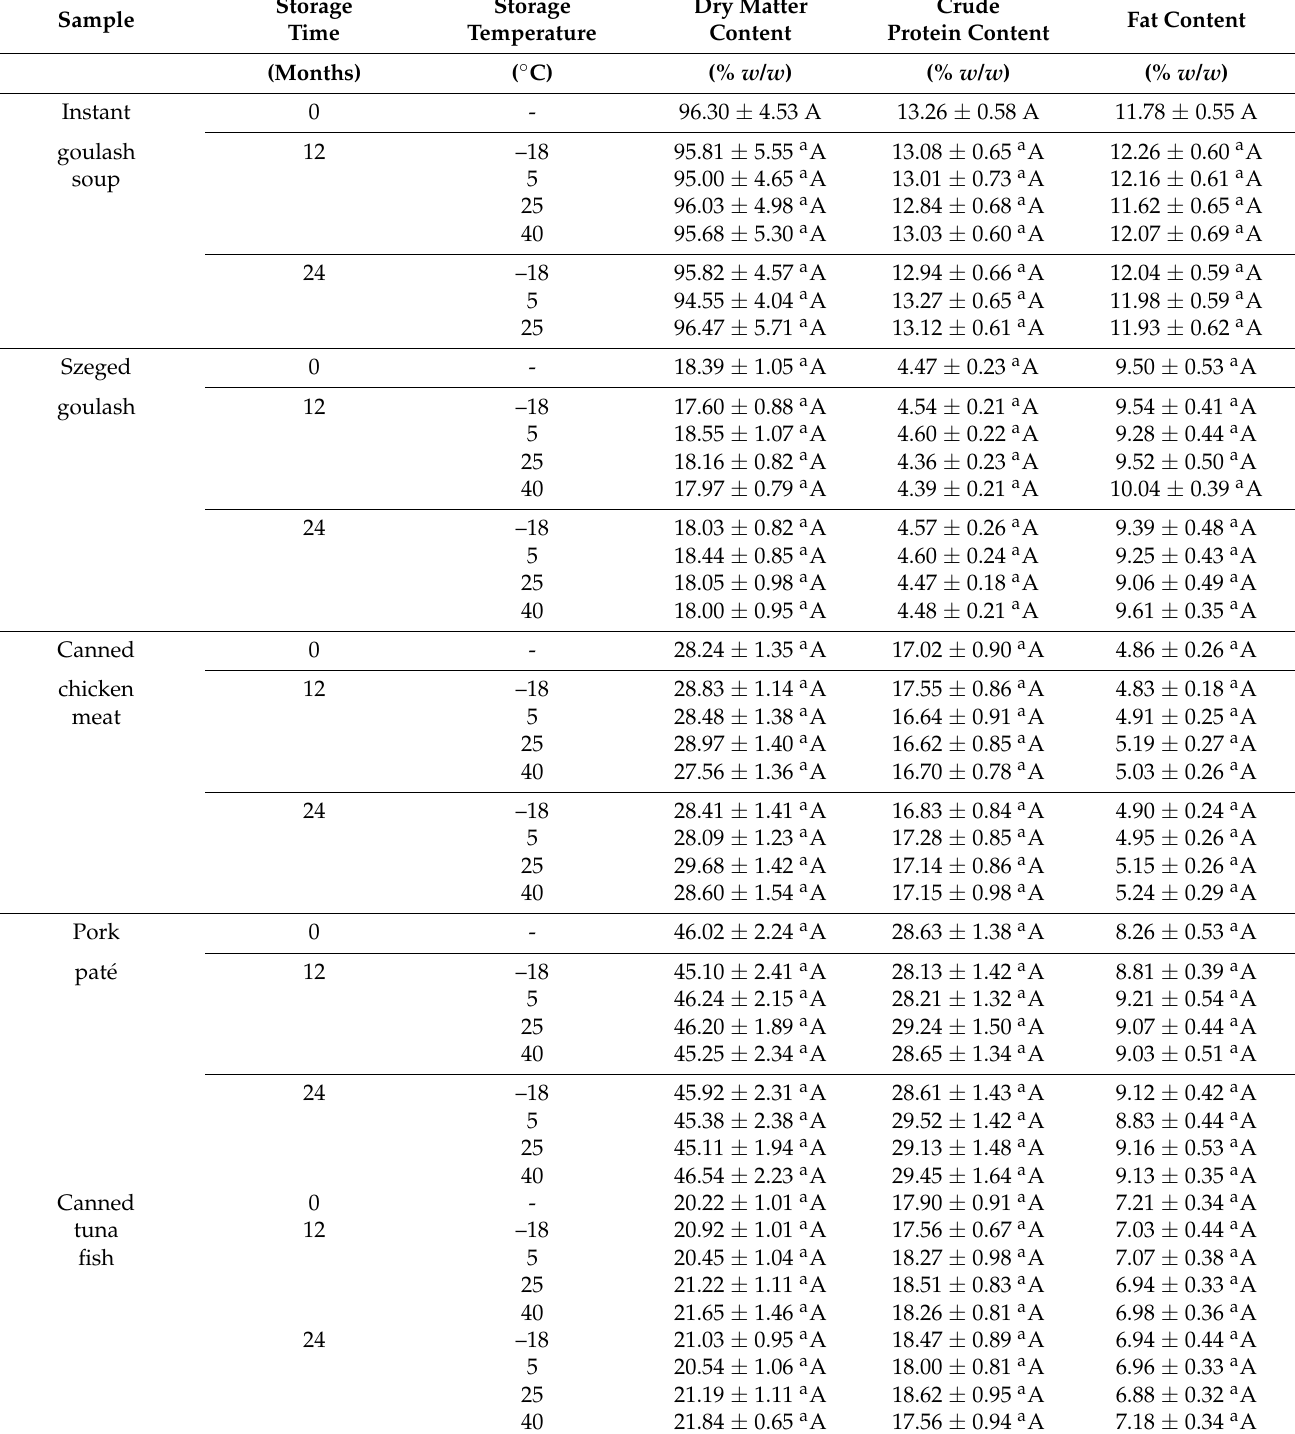
Table 2. Result of the dry matter content (% w / w ), crude protein content (% w / w ) and fat content (% w / w ) during 24-month period at four different temperatures ( − 18 ◦ C, 5 ◦ C, 25 ◦ C and 40 ◦ C). Instant goulash soup, Szeged goulash, canned chicken meat, pork p â t é and canned tuna fish were tested. The results are expressed as means ± standard deviation ( n = 27)